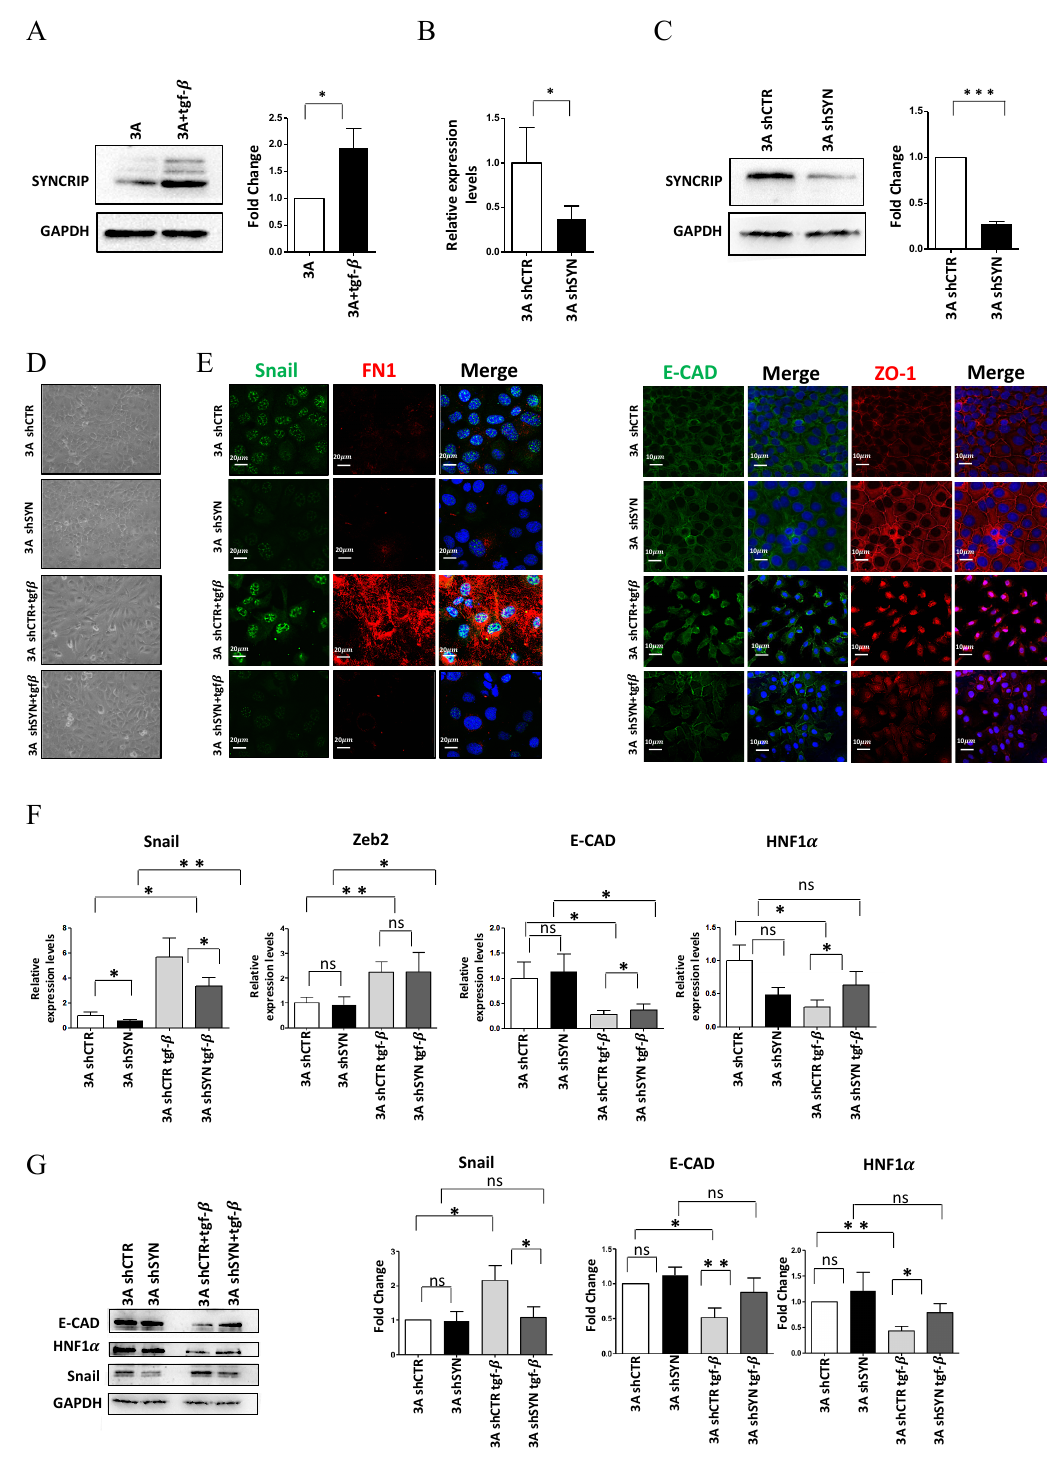
Figure 1. SYNCRIP is involved in TGF β -induced EMT of hepatocytes. ( A ) Western blot analysis of intracellular levels of SYNCRIP in hepatocytes (3A) treated or not for 24 h with TGF β . GAPDH